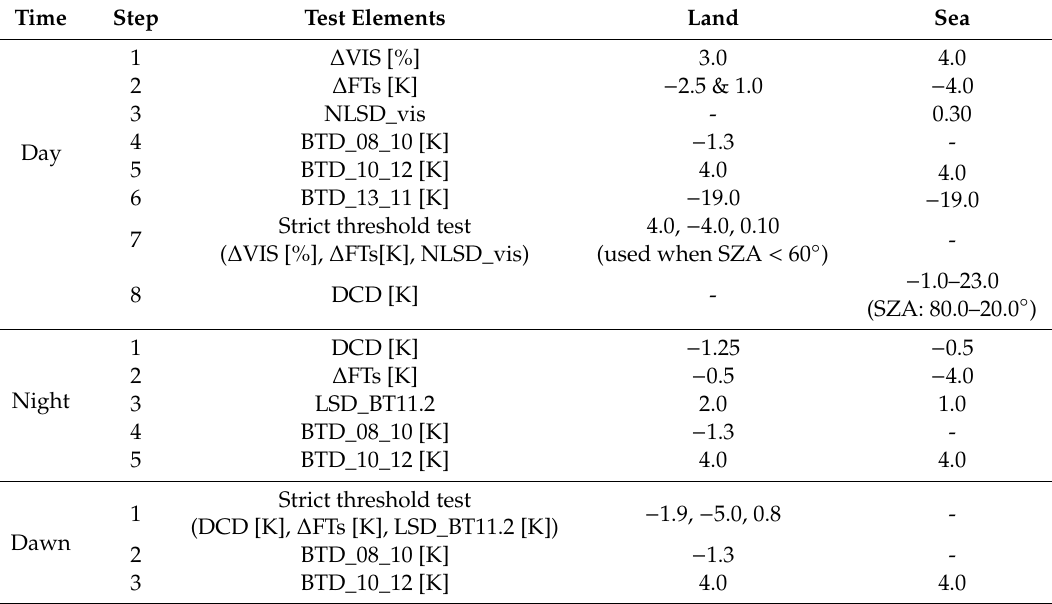
Table 3. Summary of the threshold values of the test elements, according to time and geographic location. The calculation method of each test element is described in Table A1 in Appendix